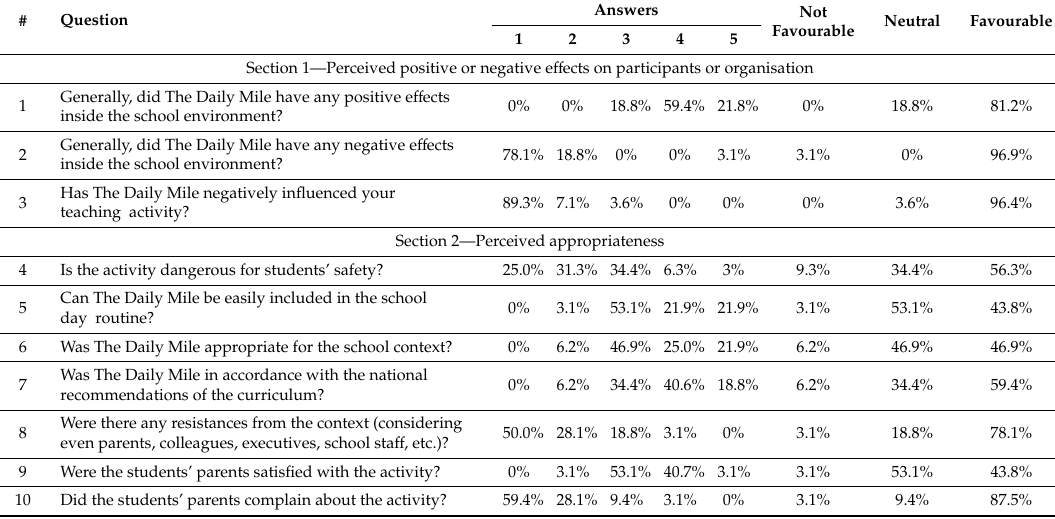
Table 1. Teachers’ survey on the feasibility of the study in terms of acceptability, perceived appropriateness, and